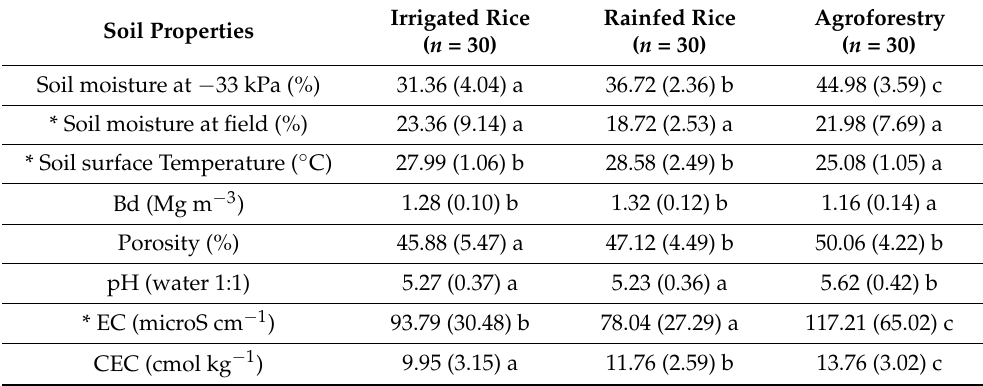
Table 2. Physical and chemical properties of soil at a depth of 0 to 10 cm in each field. Soil